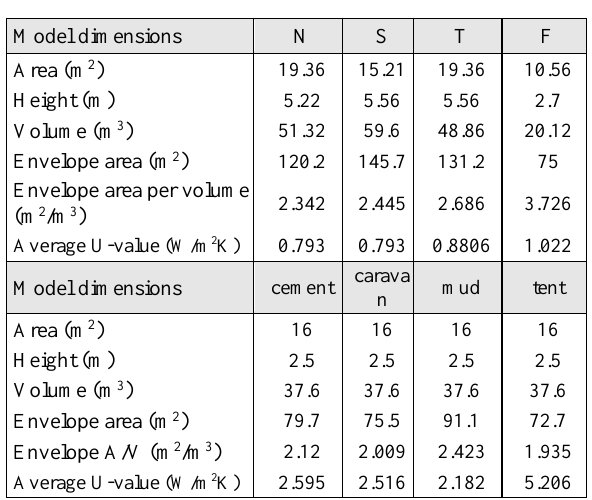
Table 2. Geometry and thermal pro the investigated models.